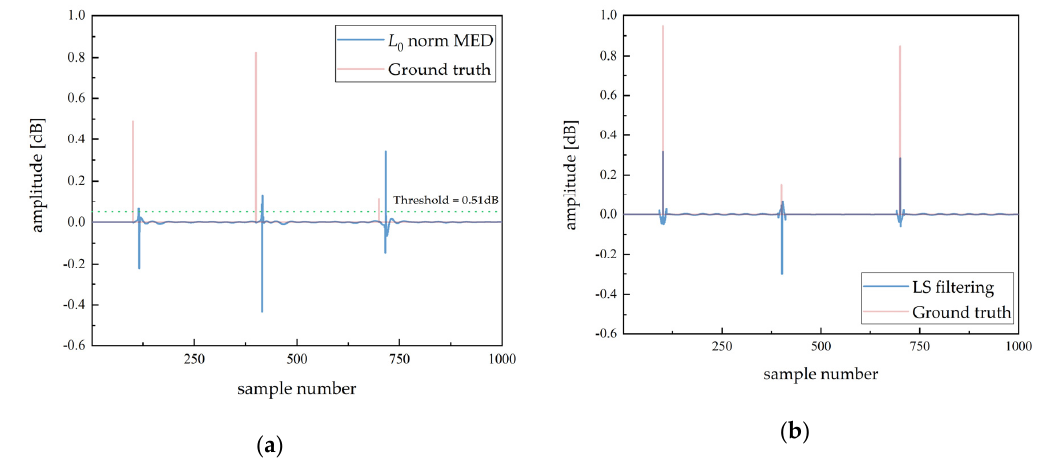
Figure 3. Comparison of parametric methods: ( a ) (cid:96) 0 norm MED (the threshold is used to determine detection points); ( b ) LS algorithm.